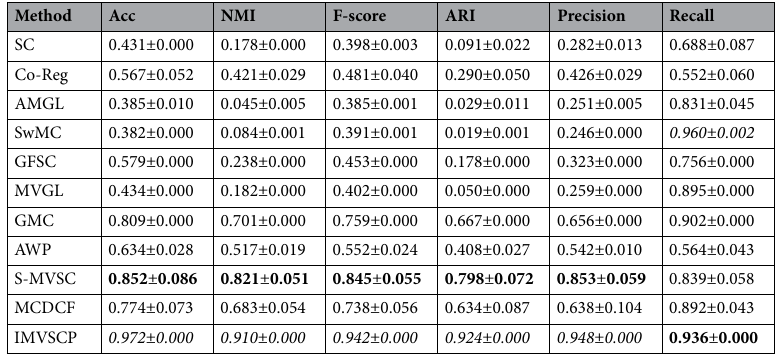
Table 2. Experimental results (mean standard deviation) on the BBCSport dataset. Significant values are in [bold/italics].